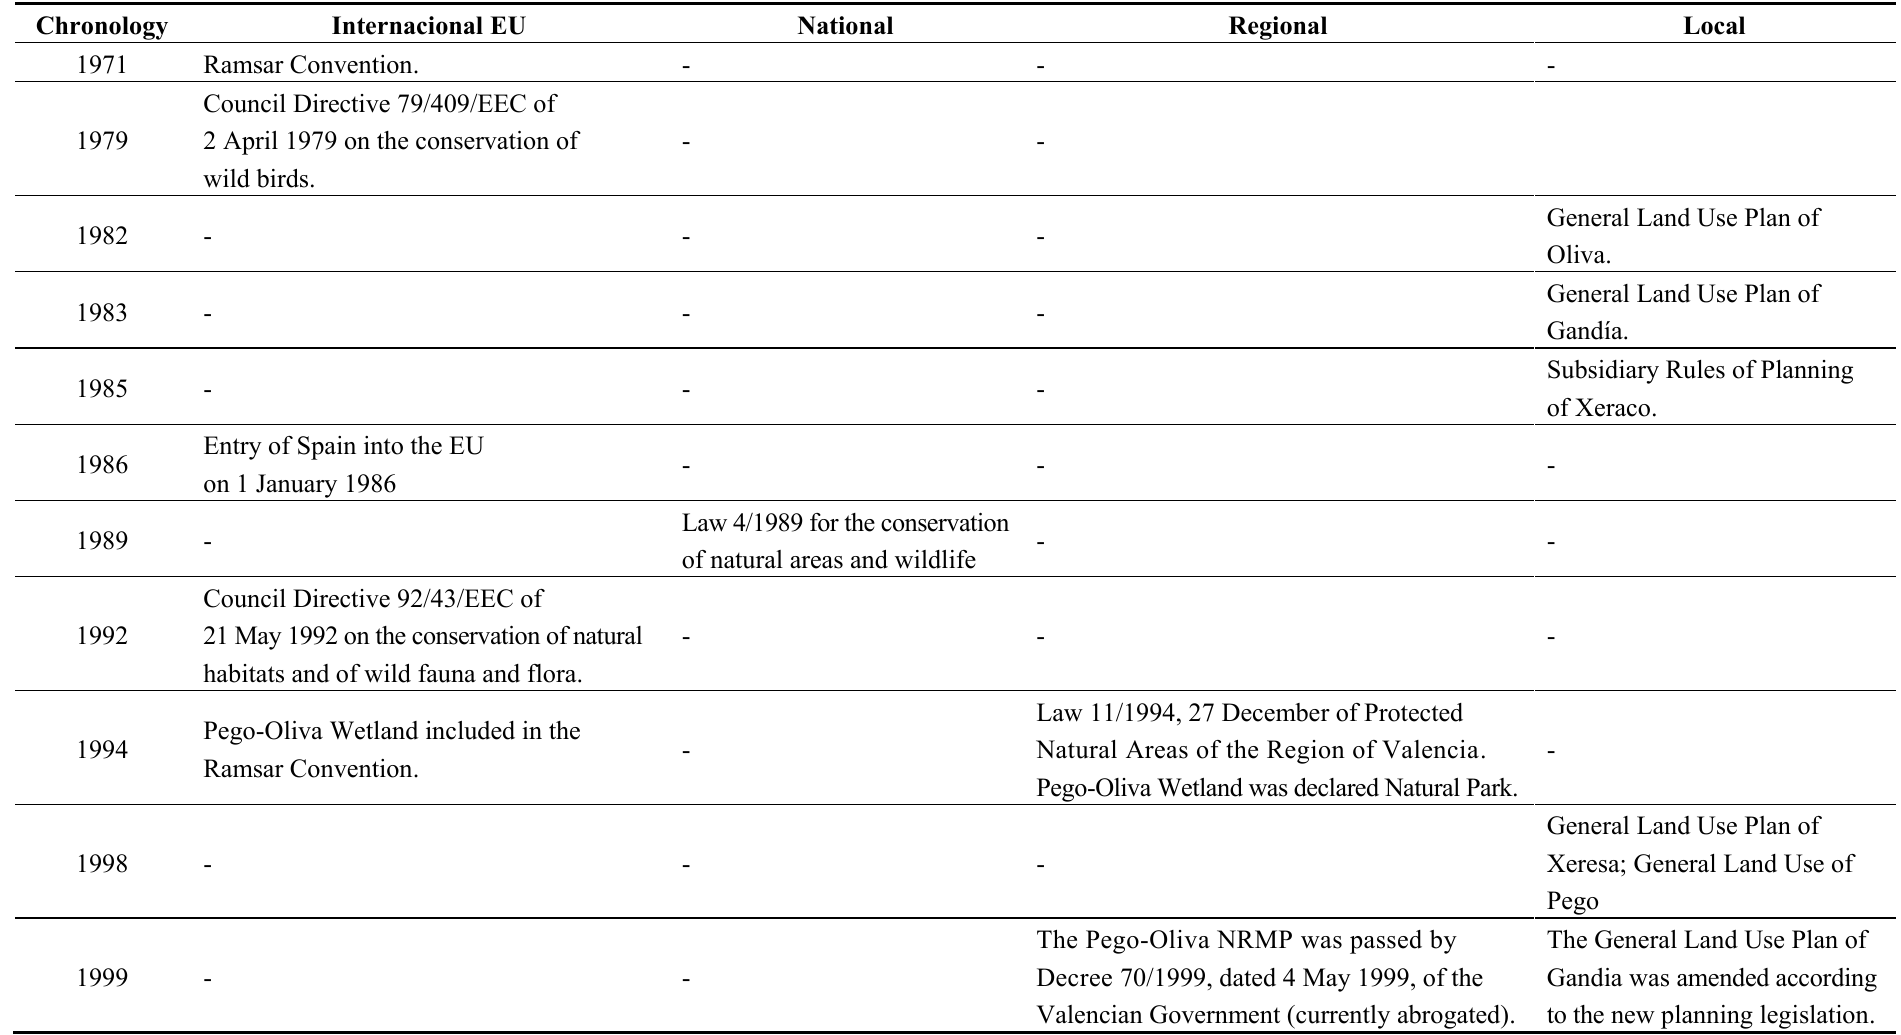
Table 2. Regulations and Plans in force on the wetlands of Region of Valencia (Spain). EU: European Union; and NRMP: Natural Resource Management